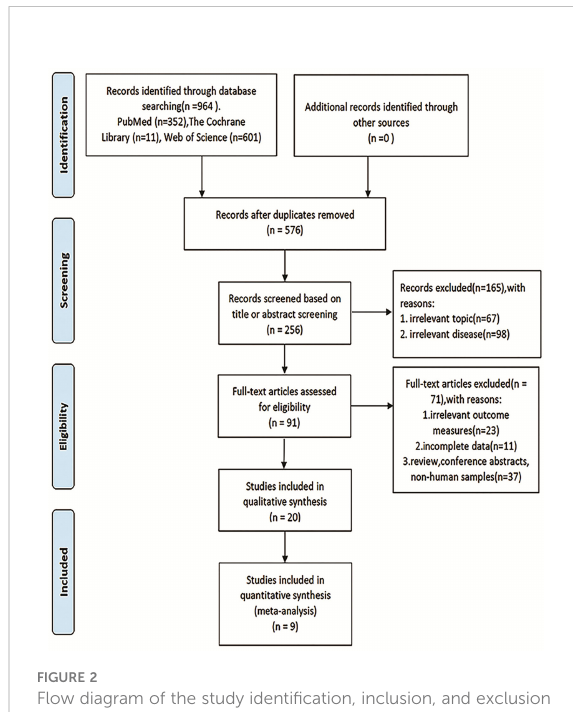
FIGURE 2 Flow diagram of the study identi fi cation, inclusion, and exclusion